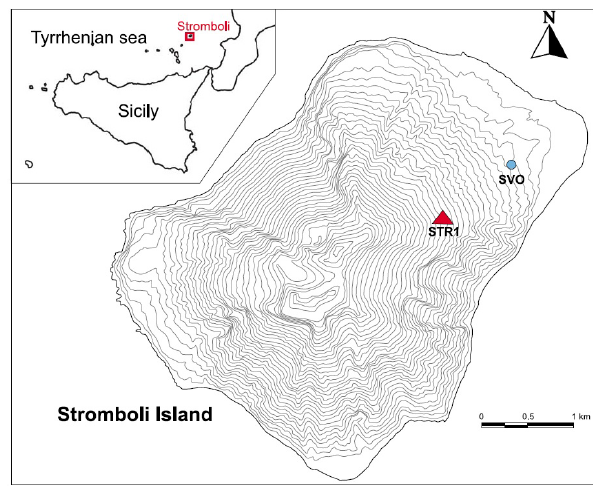
Figure 1. Map of location of both seismometer labelled STR1 and SX15 and strainmeter labelled SVO in